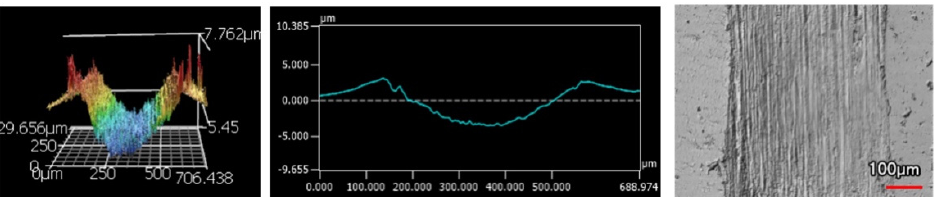
Figure 17. 9 μ m Thick Ni-P Coating 100 Passes of the Spherical Indenter. Figure 17. 9 µ m Thick Ni-P Coating 100 Passes of the Spherical Indenter.